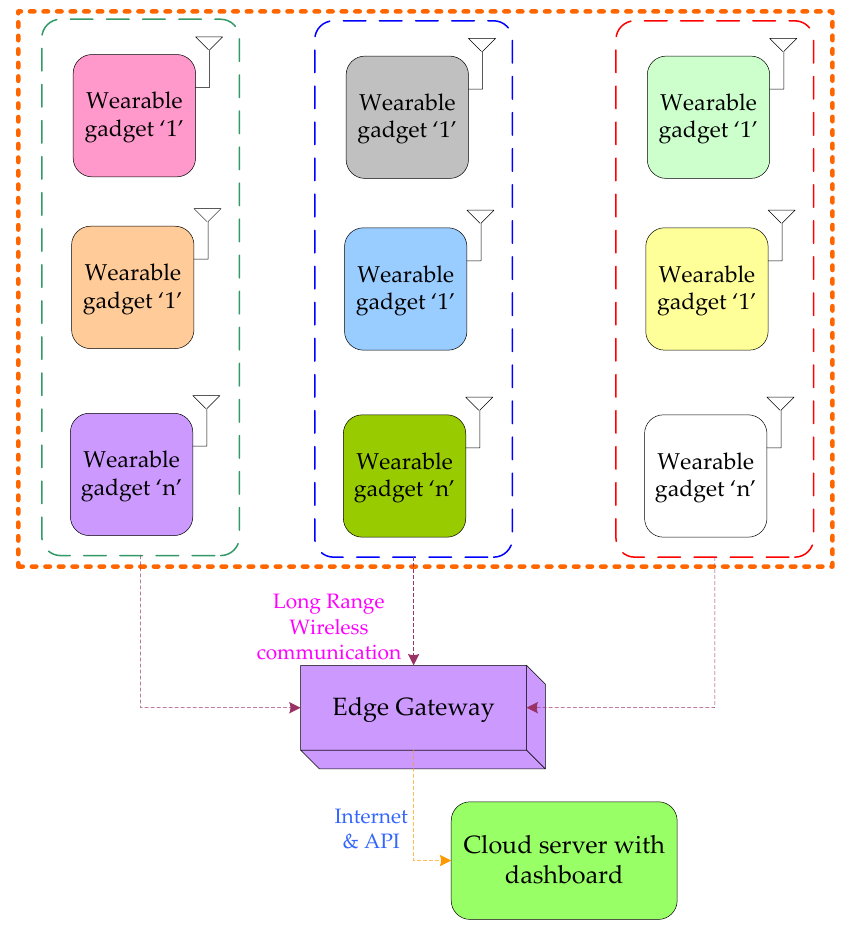
Figure 5. Wearable Gadget with edge gateway.